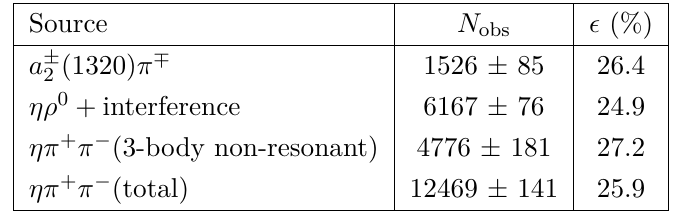
Table 1 . The numerical results for each component summed over all energy points, while those for N are statistical only. The number from ηπ + π − (total) is obtained by a fit to the M obs The uncertainty on the efficiencies for individual contributions is 0.2%, while below 0.1% for the ηπ + π − (total), which is negligible.